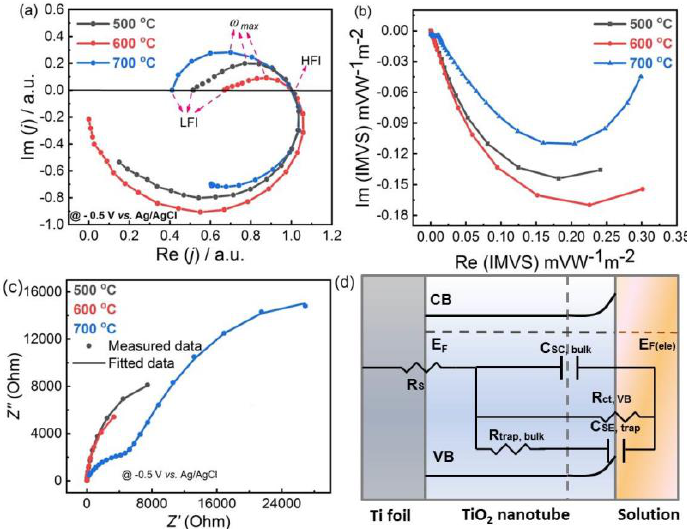
Figure 7. Representative perturbative PEC spectroscopy plots of TiO 2 nanotubes annealed at different temperatures. ( a ) Intensity-modulated photocurrent spectroscopy (IMPS, normalized), spectra measured at – 0.5 V vs. Ag/AgCl. ( b ) Intensity-modulated photovoltage spectroscopy (IMVS) measured under open circuit conditions. ( c ) Photoelectrochemical impedance spectroscopy (PEIS) measured at – 0.5 V vs. Ag/AgCl. ( d ) Schematic of an equivalent circuit used for fitting. Rs is the contact/solution resistance, R trap,bulk is the bulk charge transport resistance, R ct,VB is the charge transfer resistance across the semiconductor/electrolyte interface. C SC,bulk is the space charge layer capacitance, C SE,trap represents the capacitance of the semiconductor/electrolyte interface. All measurements were performed in 1 M NaOH electrolyte.